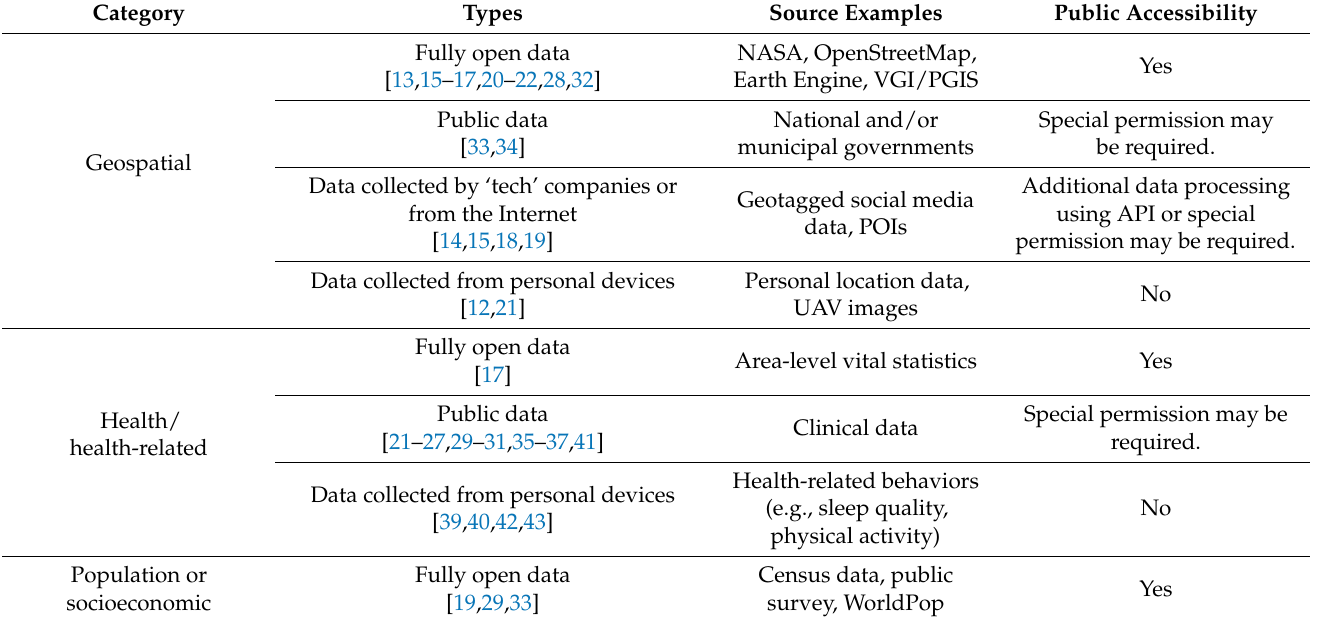
Table 5. Data sources